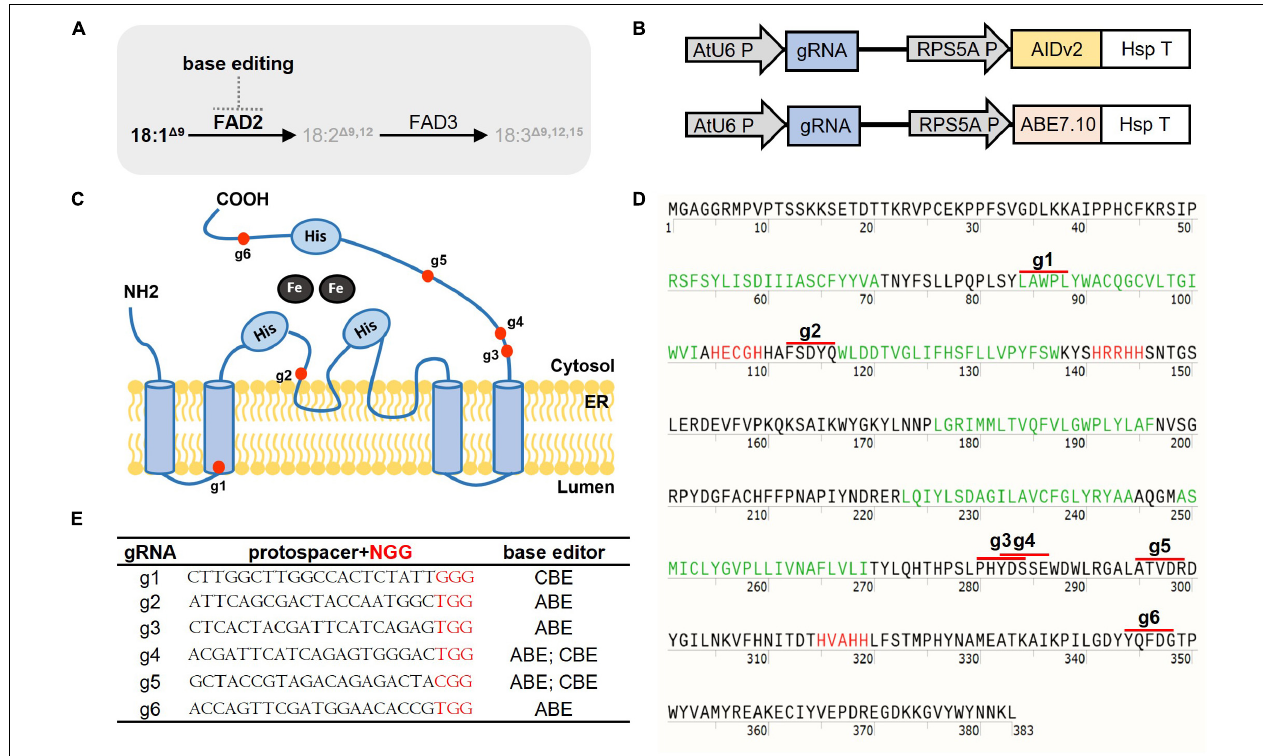
FIGURE 1 | “Semi-random” base editing strategy for selected FAD2 coding regions. (A) The function of FAD2 in desaturation of fatty acids and potential BE action in Arabidopsis seeds. FAD2 desaturates 18:1 (cid:49) 9 to 18:2 (cid:49) 9 , 12 . FAD2 is subjected to base editing to alter its function. (B) Core structures of the CRISPR part in T-DNA from binary vectors harboring CBE and ABE in this study. gRNA expression is controlled by the U6 promoter, and AIDv2-dependent CBE and ABE7.10 are under the control of RPS5A promoters. (C) A schematic diagram of the FAD2 protein structure adapted from Zhang et al. (2012) ER-located FAD2 has six transmembrane domains and three histidine box motifs (His). Red dots denote BE target regions. (D) The FAD2 amino-acid sequence. Arabidopsis FAD2 is composed of 383 amino acids. Green-colored sequences indicate transmembrane domains, red-colored sequences indicate His motifs, and red lines indicate the potential amino acids that might be affected by BE targeting via corresponding gRNAs. (E) A list of selected gRNAs used for CBE and/or ABE with a protospacer sequence for FAD2 editing in this